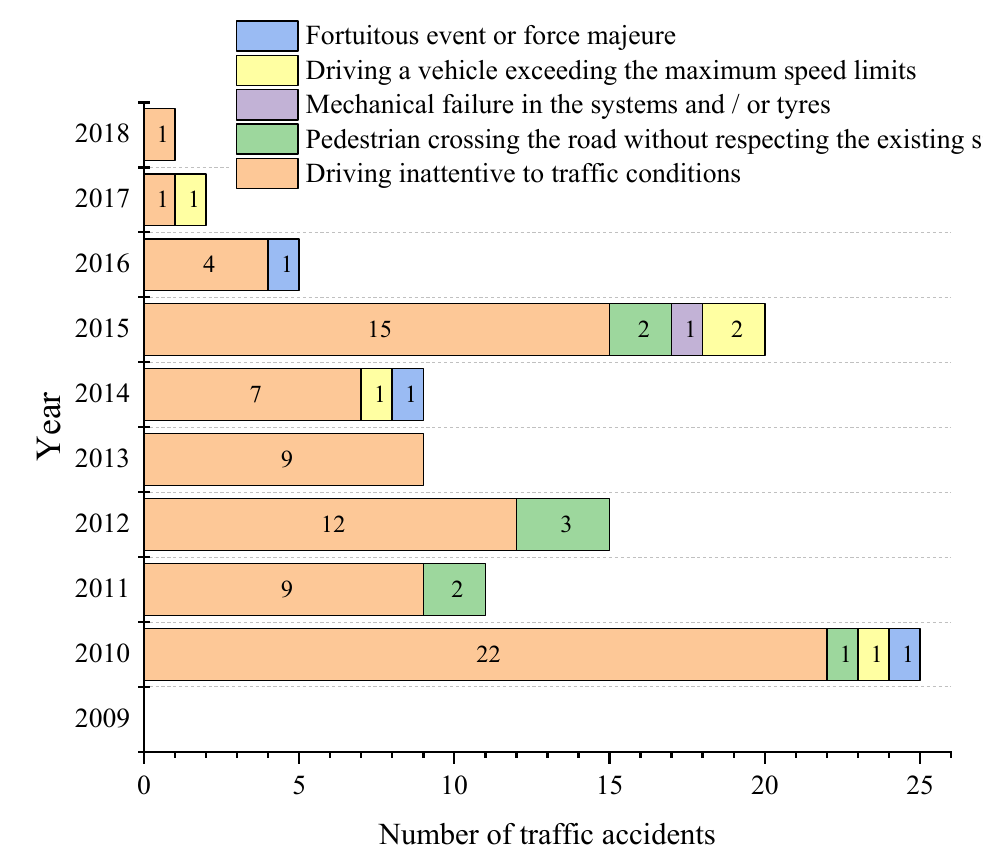
Figure 16. Traffic accident causes per year for subcategory M1.